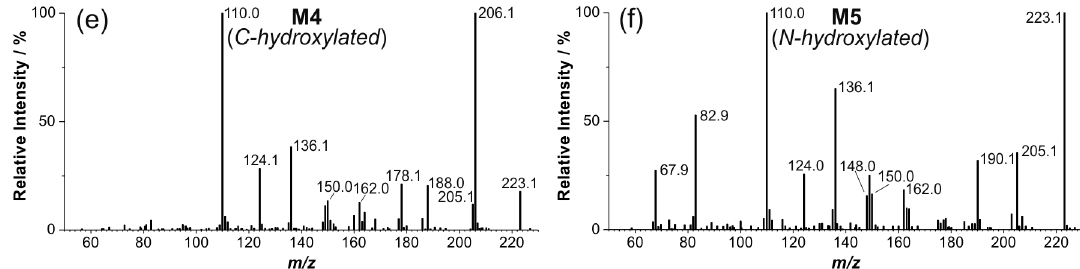
Figure 5. Enhanced product ion (EPI) spectra of: ( a ) rac - 1 (product of m / z 207.1, CE 70, CES 25); and ( b – f ) metabolites M1 to M5 (products of m / z 223.1, CE 33, CES 0).